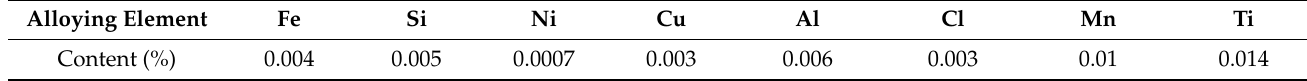
Figure 1. Schematic illustration for the fabrication process of CNTs/Mg laminated composite. Table 1. Chemical composition of initial Mg foils.